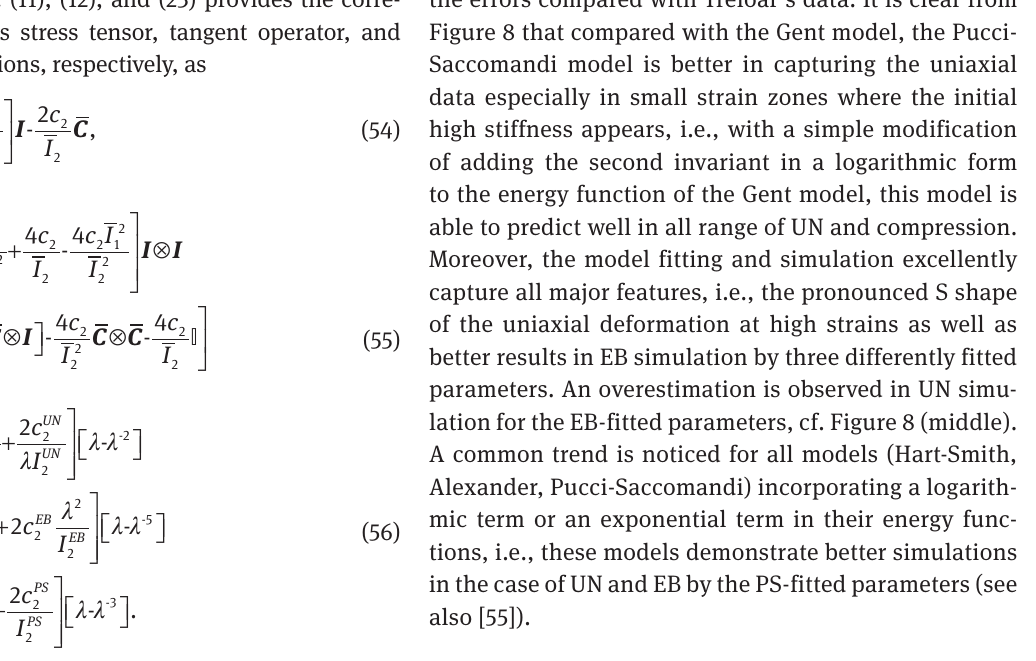
Optimizing the analytical equations of the three deformation modes to the corresponding Treloar data, the optimal material parameters are